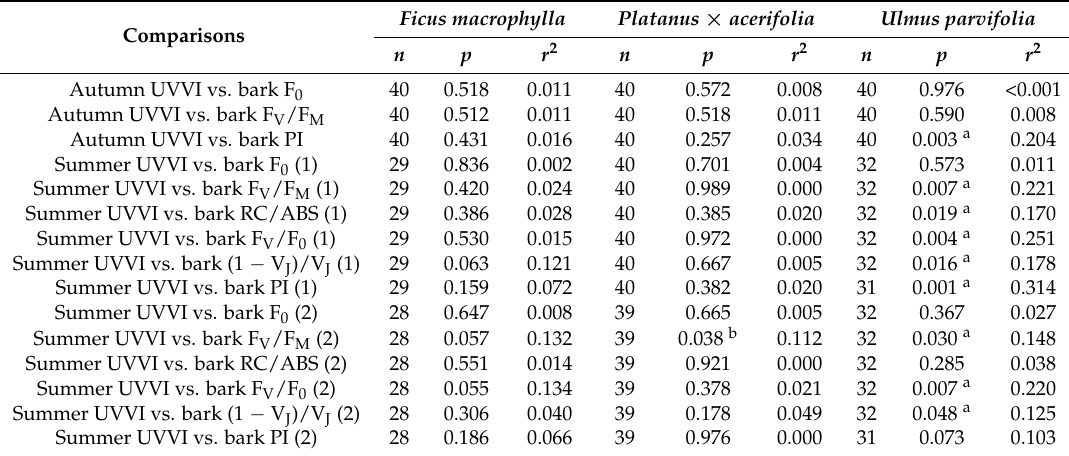
Table 3. Summarized results from simple linear regression analyses comparing autumn and summer bark fluorescence with autumn and summer urban tree visual vitality index. Linear regressions using the 95% confidence interval.